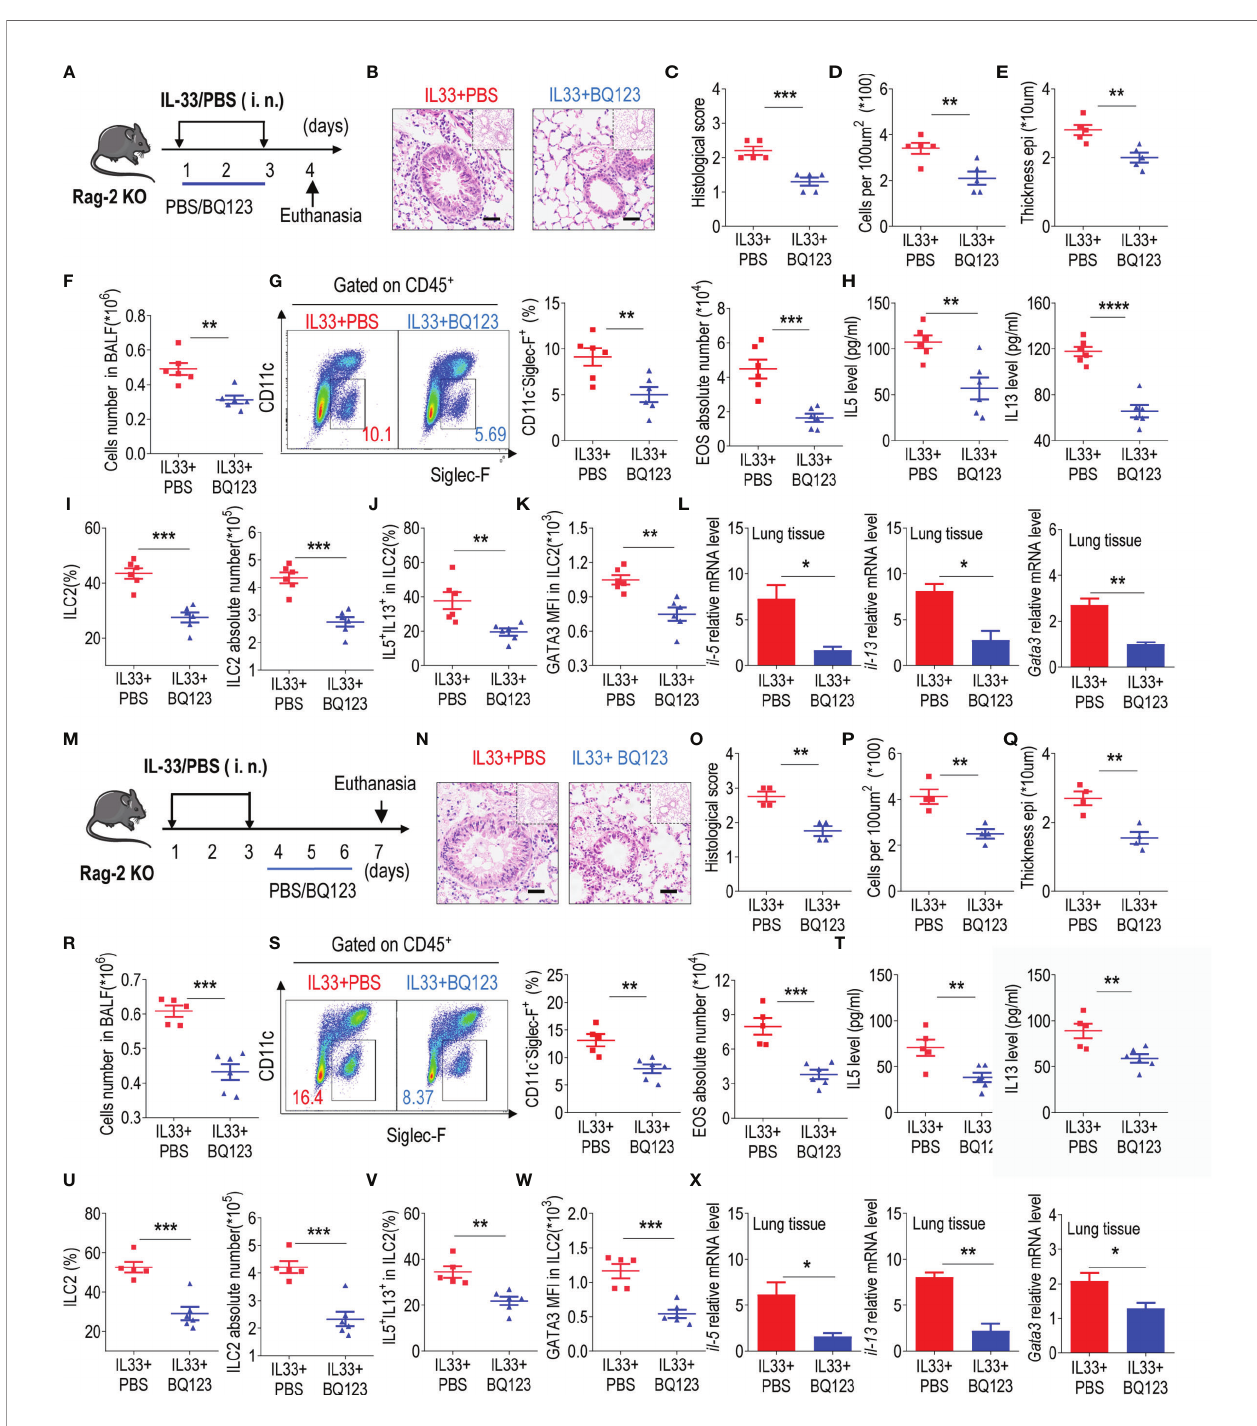
FIGURE 4 | BQ123 abrogated allergic lung in fl ammation in a T-cell-independent manner. (A, M) Experimental scheme. (B – E, N – Q) Representative hematoxylin and eosin (H&E) staining of lung sections and in fl ammation scores, as well as the in fi ltrating cells and airway epithelium thickness were shown. (F, R) Absolute number of BALF. (G, S) Typical example of fl ow cytometry (left) and statistical results (right) of population and the absolute number of EOS in the BALF were shown. (H, T) Levels of IL-5 and IL-13 in BALF. (I, J, U, V) the frequencies of ILC2s and absolute counts (I, J) , IL-5 + IL-13 + ILC2s (U, V) . (K, W) GATA3 protein level in lung ILC2s were presented. (L, X) mRNA expression levels of ILC2-related target genes in lung tissues, including Il5 , Il13 , and Gata3 , were determined; b -actin level was used for normalization, and the lowest expression level in the IL33 + BQ123 group was set to 1 (n = 3). Data are representative of two or three independent experiments (n = 6 for the preventive model; n = 5 for the therapeutic model). *P < 0.05; **P < 0.01; ***P < 0.001; ****P < 0.0001. Error bars show mean ± standard error of the mean (SEM); statistical signi fi cance was determined using a two-tailed unpaired Student ’ s t-test (C – L, O – X)